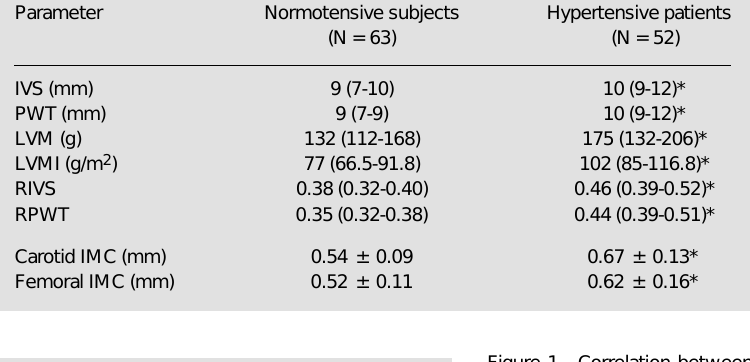
Figure 1 - Correlation between common carotid intima-media complex (IMC) and age for nor- motensive controls (N = 63) and hypertensive patients (N = 52). The equation for IMC-normo- tensives was: y = 0.398 + (0.0034 x age) and for IMC-hy- pertensives: y = 0.405 + (0.0052 x age). The intercepts, but not the slopes, were